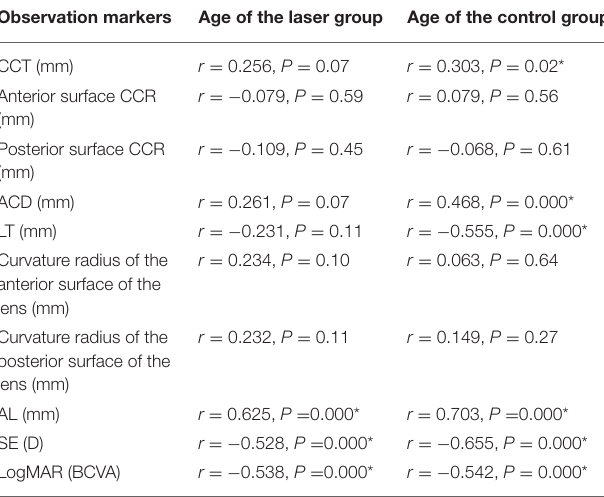
TABLE 3 | Correlations of age with eye biology and refractive status in the laser and control groups. Observation markers